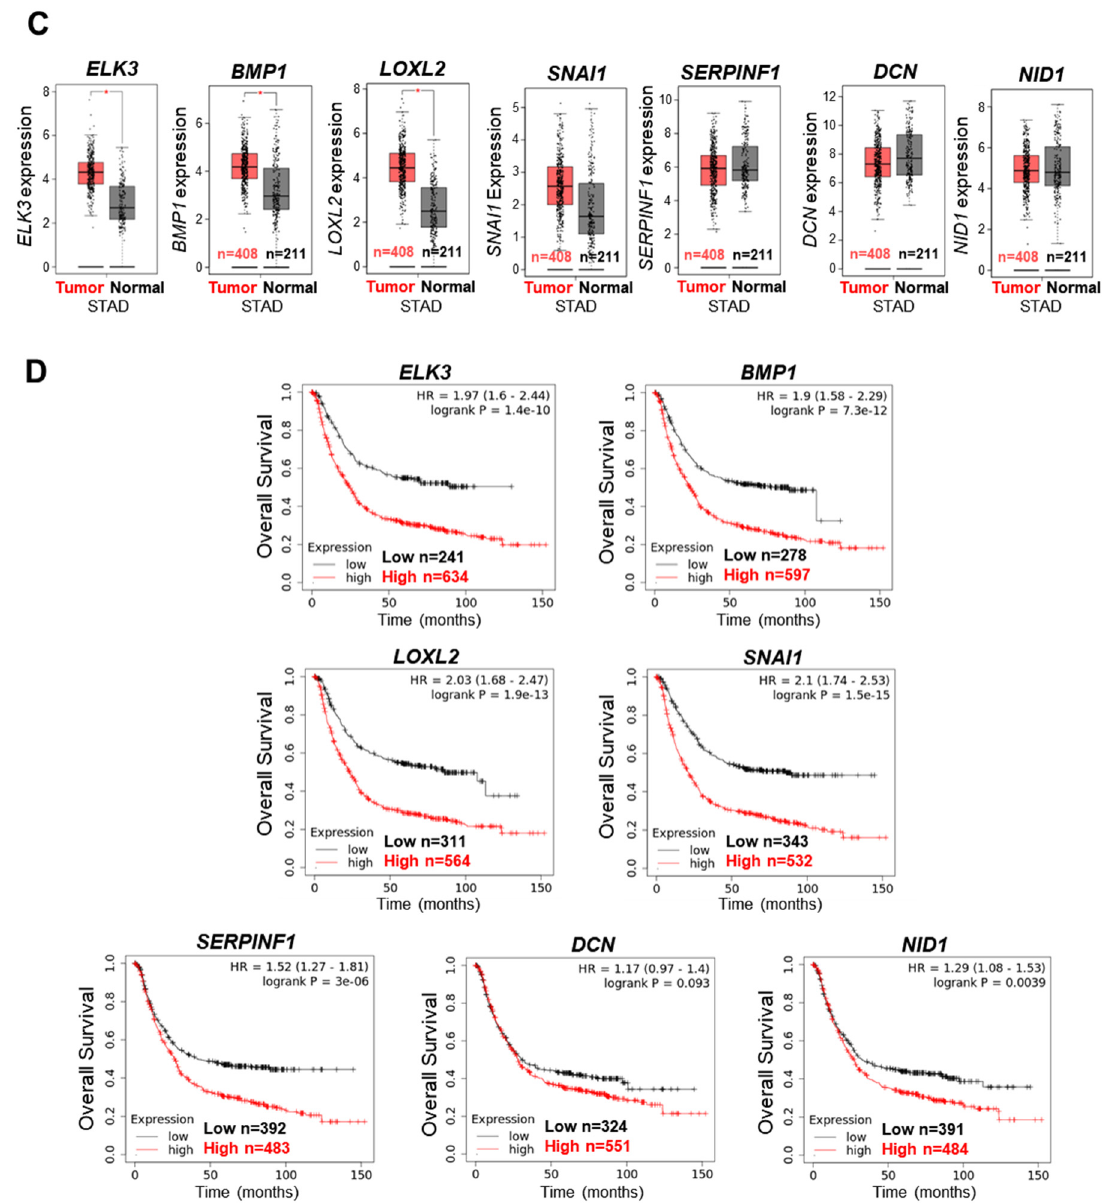
Figure 7. ELK3 positively regulates ECM remodeling-related genes in gastric cancer cells and patient tissues. ( A ) Dot plots illustrating the correlation between ELK3 and the indicated genes. Each dot denotes a single cell line. Red dots denote SNU638 and MKN1 cells used in the present study. All cell lines expression data were obtained from the Cancer Dependency Map database. p < 0.05 was considered to indicate a statistically significant difference. ( B ) Correlation plot illustrating the link between ELK3 and the indicated genes in patients with gastric cancer. Each dot denotes a single patient. p < 0.05 was considered to indicate a statistically significant difference. ( C ) Box plots illustrating the expression of the indicated genes in samples from patients with gastric cancer (n = 408) and healthy samples (n = 211). p < 0.05 was considered to indicate a statistically significant difference. ( D ) Kaplan-Meier survival plots showing the overall survival of patients with gastric cancer with high or low expression of the indicated genes. All patient data were obtained from the Cancer Genome Atlas. p < 0.05 was considered to indicate a statistically significant difference. STAD, stomach